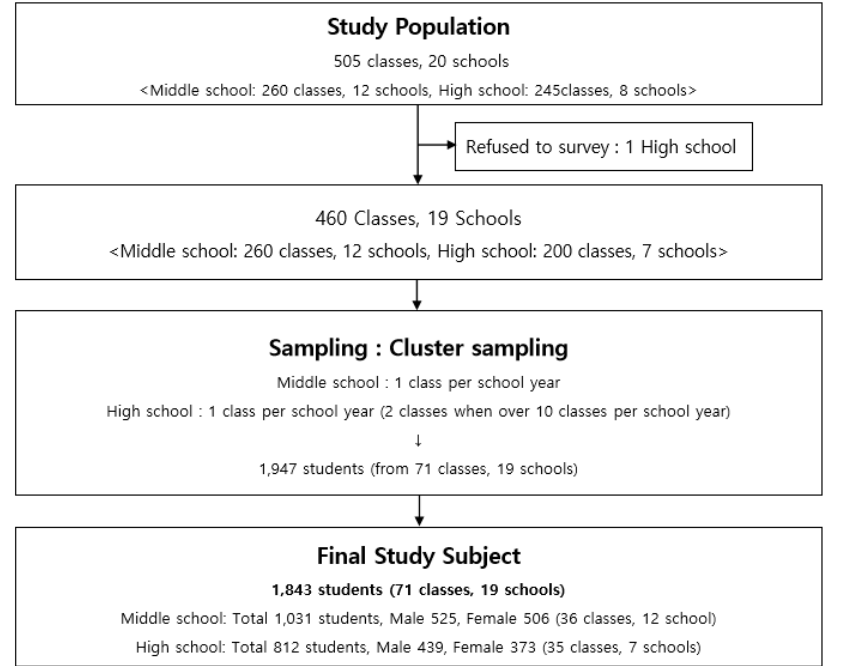
Figure 2. Prevalence survey for non-suicidal self-injury in South Korea, 2019. The cluster-random sampling method was used to increase the efficiency. The in- vestigation unit was a class; every school’s data were stratified based on the school